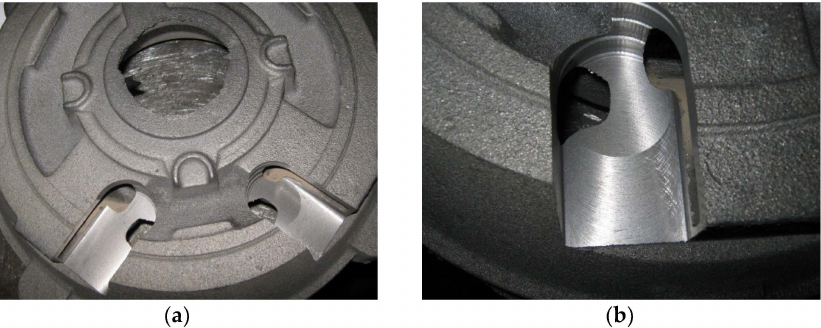
Figure 20. ( a ) Appearance of disc casting (no porosity-type defects) after applying special inoculation of cast iron with underestimated sulphur content of 0.02%, and ( b ) inoculated cast iron with sulphur content of